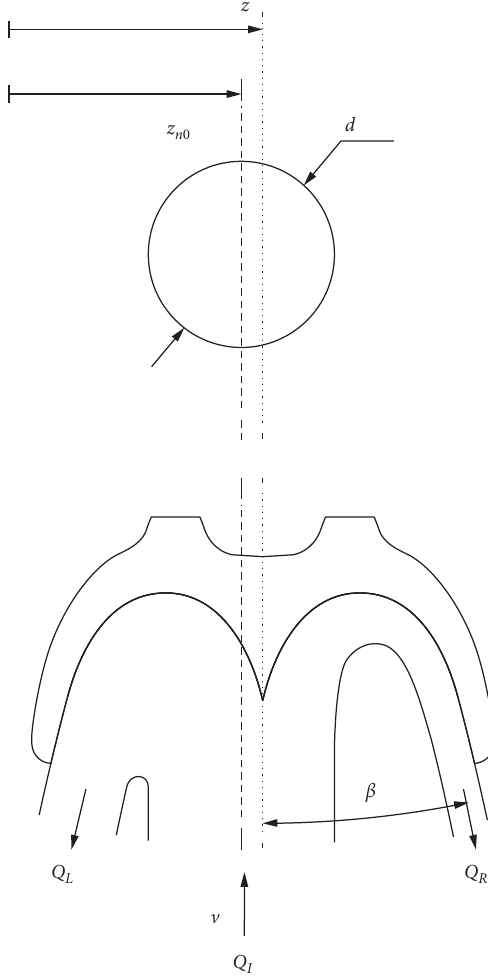
Figure 4: Uneven separation of water jet in Pelton turbine